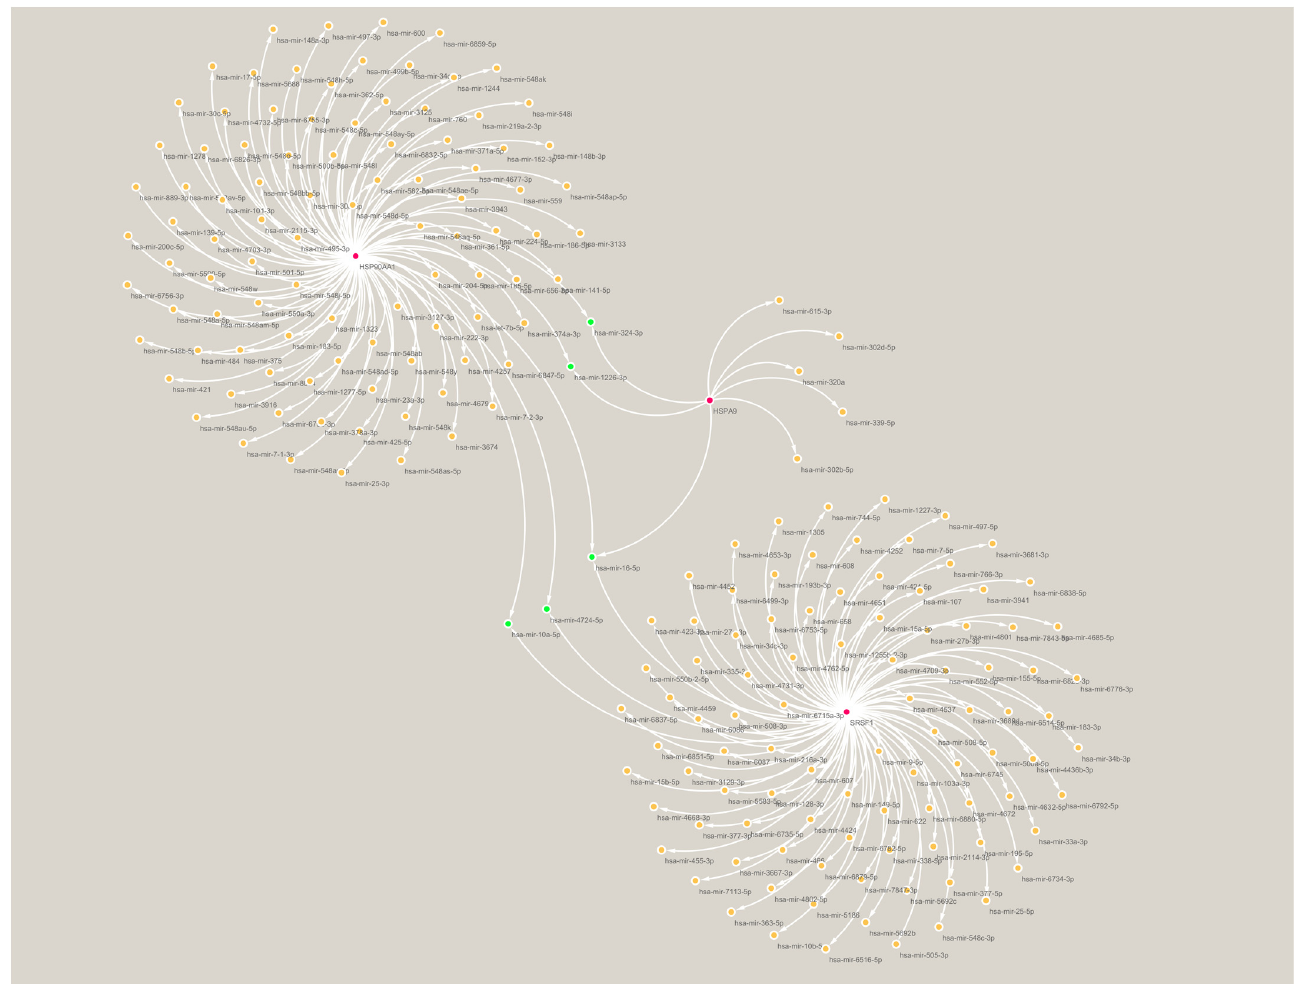
Figure 7. miRNA–mRNA regulatory network of the three hub genes. Red indicates hub genes, green indicates miRNAs associated with at least two of the hub genes.